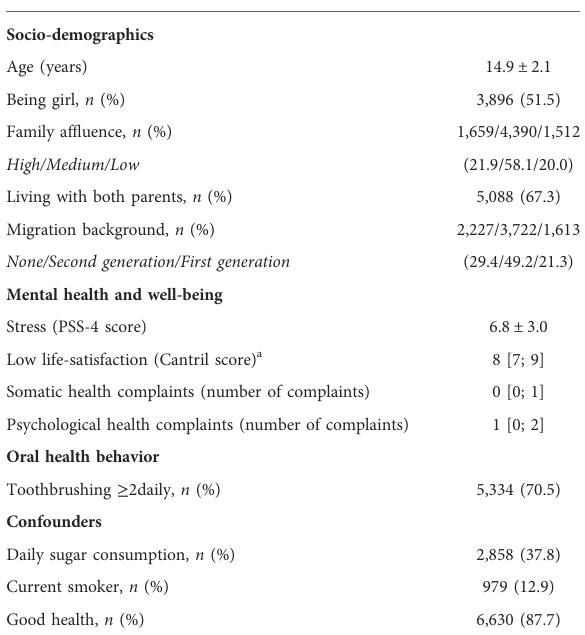
TABLE 1 Characteristics study sample.